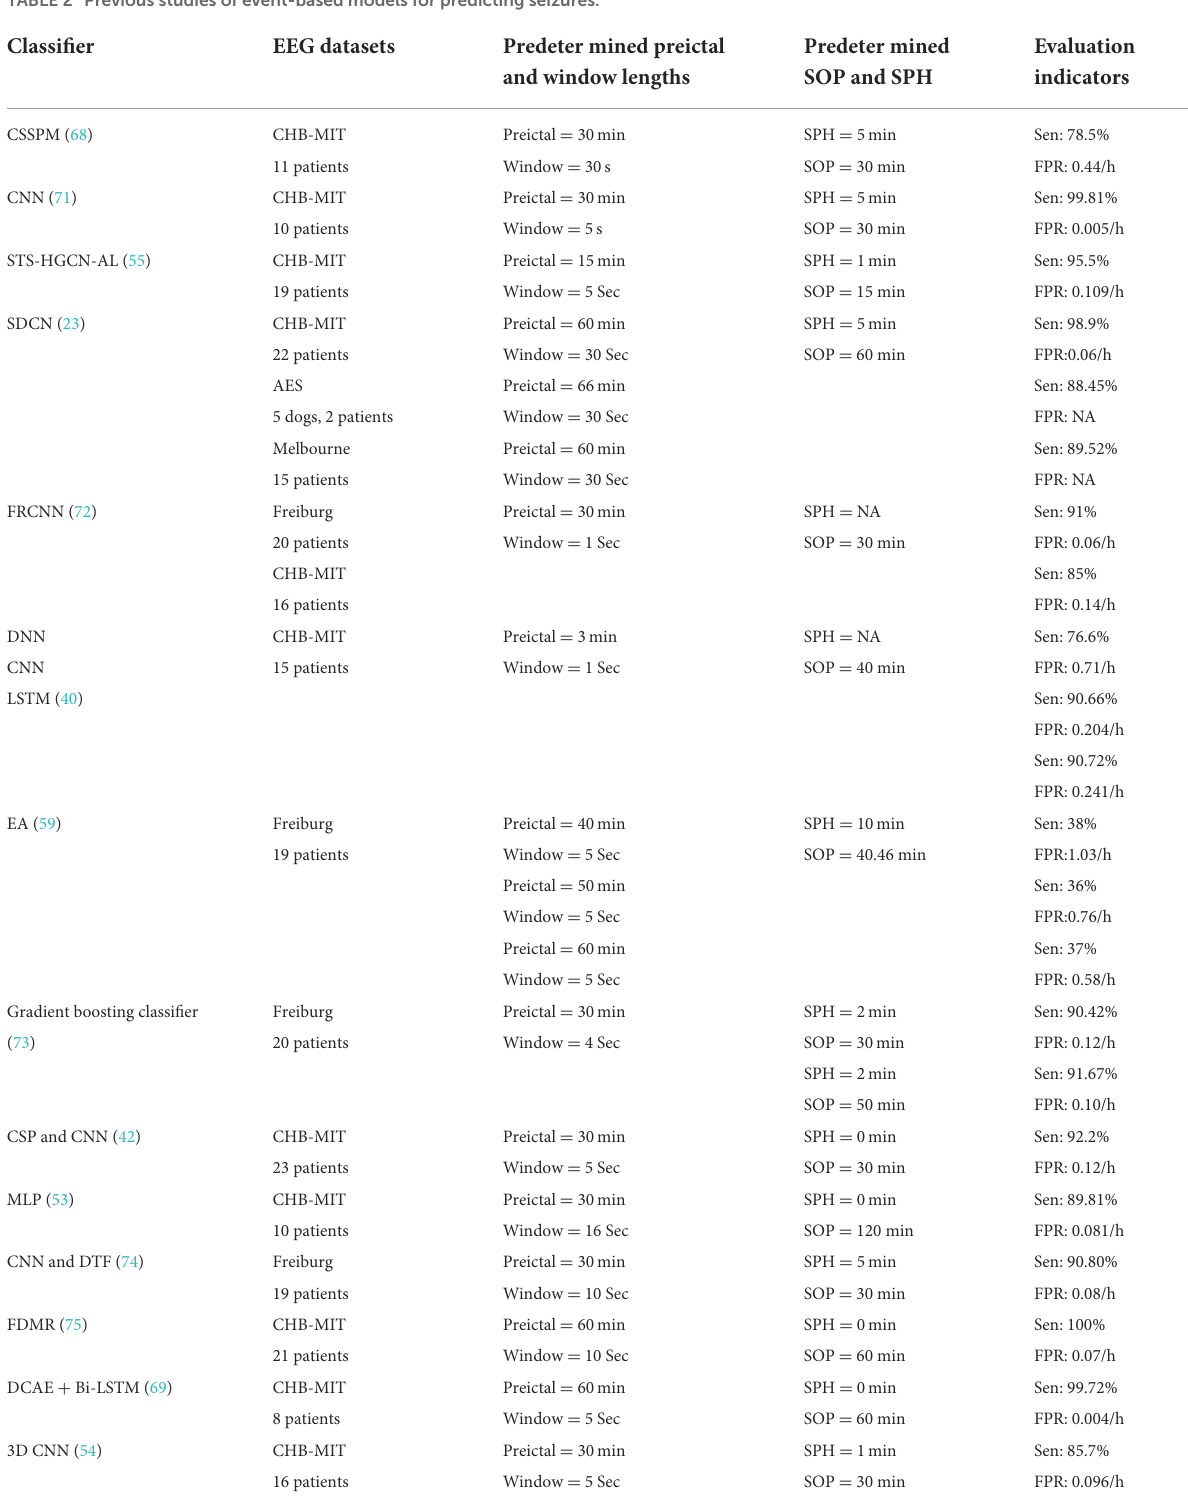
TABLE 2 Previous studies of event-based models for predicting